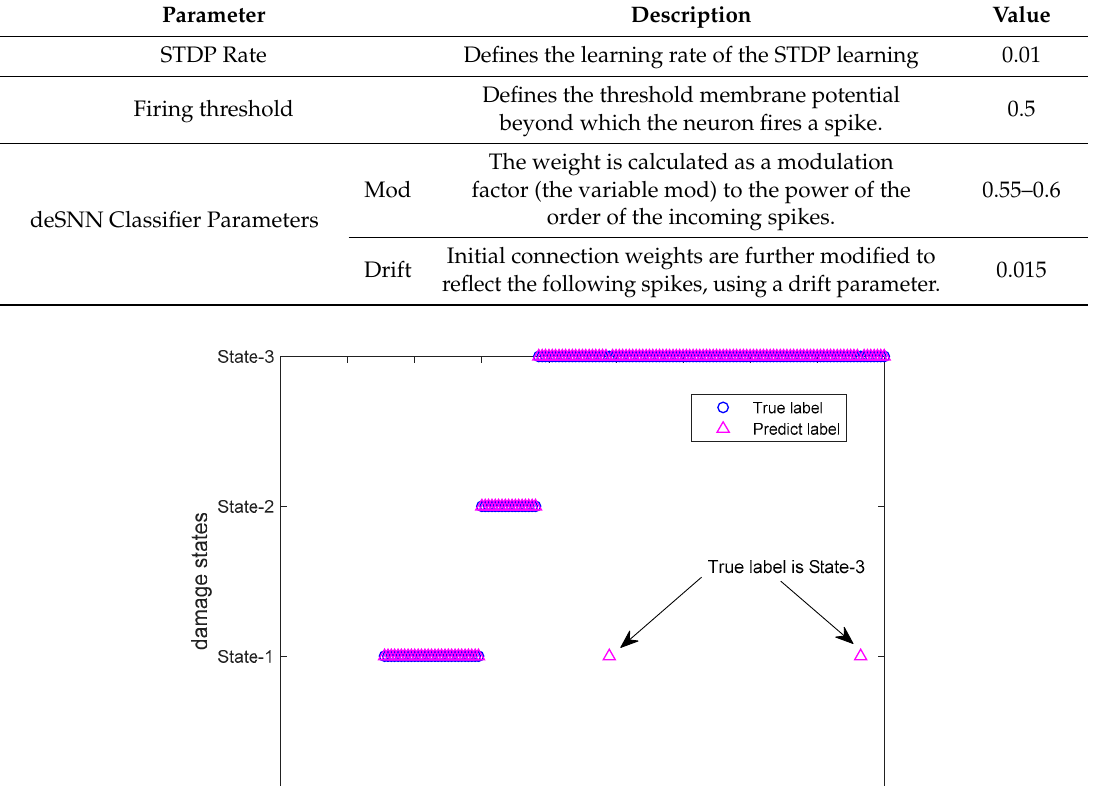
Table 4. NeuCube Model Parameter Setting.